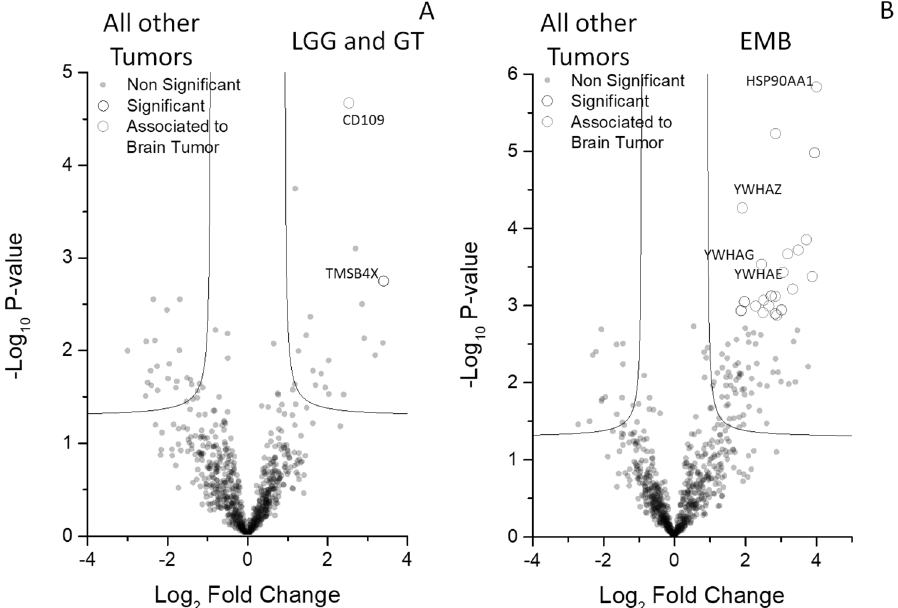
Figure 3. Volcano plots of CSF proteome from EVD of LGG and GT and EMB compared with all other classes of brain tumor. Volcano plot for ( A ) LGG and GT or ( B ) EMB compared with all other brain tumor samples. Grey, open black and red circles indicate the changes for the non-significant, significant or previously described as associated to brain tumor proteins among the two groups, respectively. Black line indicates the limits of statistically significant. Grey circles above the black line indicate the proteins with an identity <